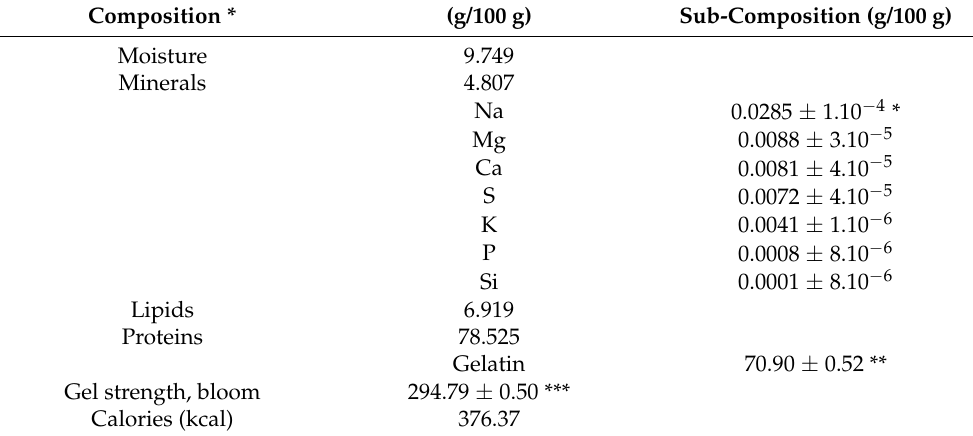
Table 2. Composition analysis of powdered gelatin from chicken feet.